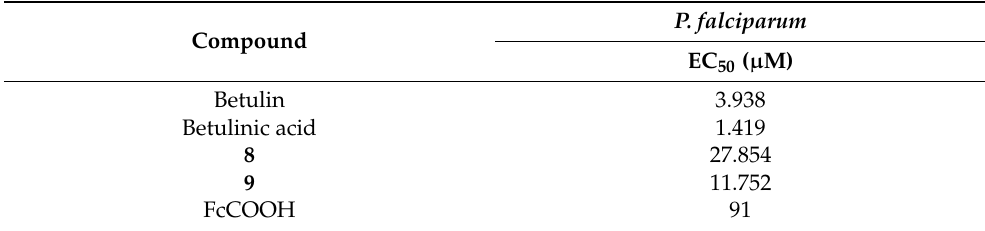
Figure 4. Betulin-modified ferrocenes. Table 2. EC 50 values of betulin, betulinic acid, hybrids 8 , 9 and ferrocenecarboxylic acid against Plasmodium falciparum ; data from [5].